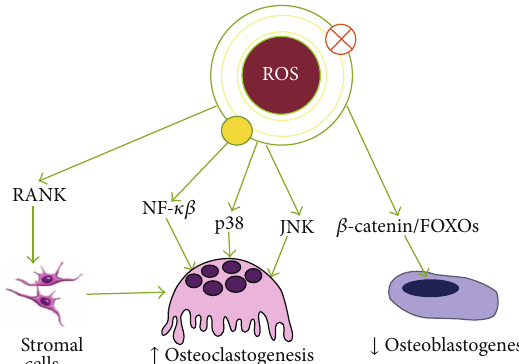
Figure 1: ROS-activated signalling pathways affecting the genesis of osteoblasts and osteoclasts. In osteoclast precursors, RANKL- induced activation of RANK stimulates ROS production, which is important for osteoclastogenesis. ROS-induced bone resorption occurs through the modulation of kinases and transcription factor activities in both osteoclasts and